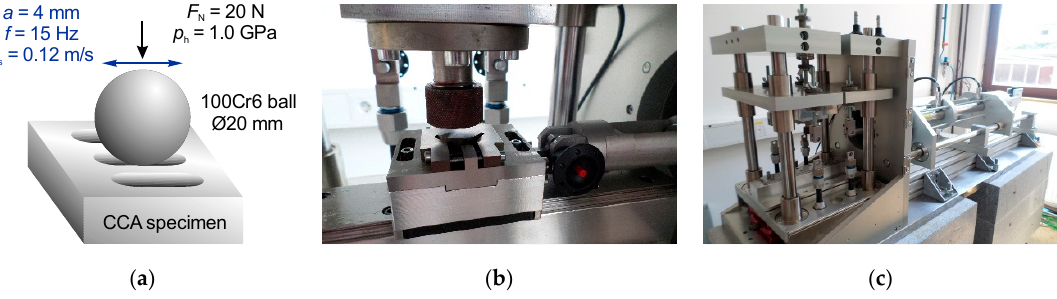
Figure 2. Ball-on-plate configuration used for wear tests: ( a ) Schematics with test parameters; ( b ) Configuration in the actual testing rig; ( c ) The device used for wear tests.